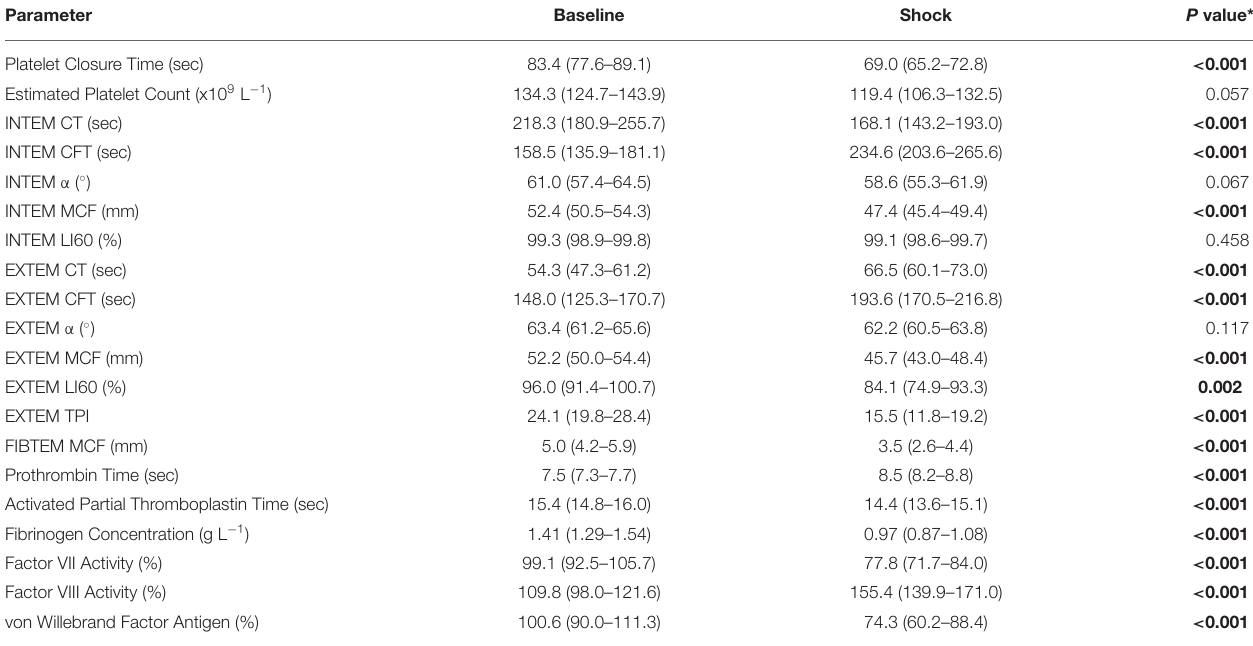
TABLE 5 | Platelet closure time and count, rotational thromboelastometry, and plasma coagulation assay parameters (mean, 95% confidence interval) in dogs ( n = 24) with hemorrhagic shock. Parameter